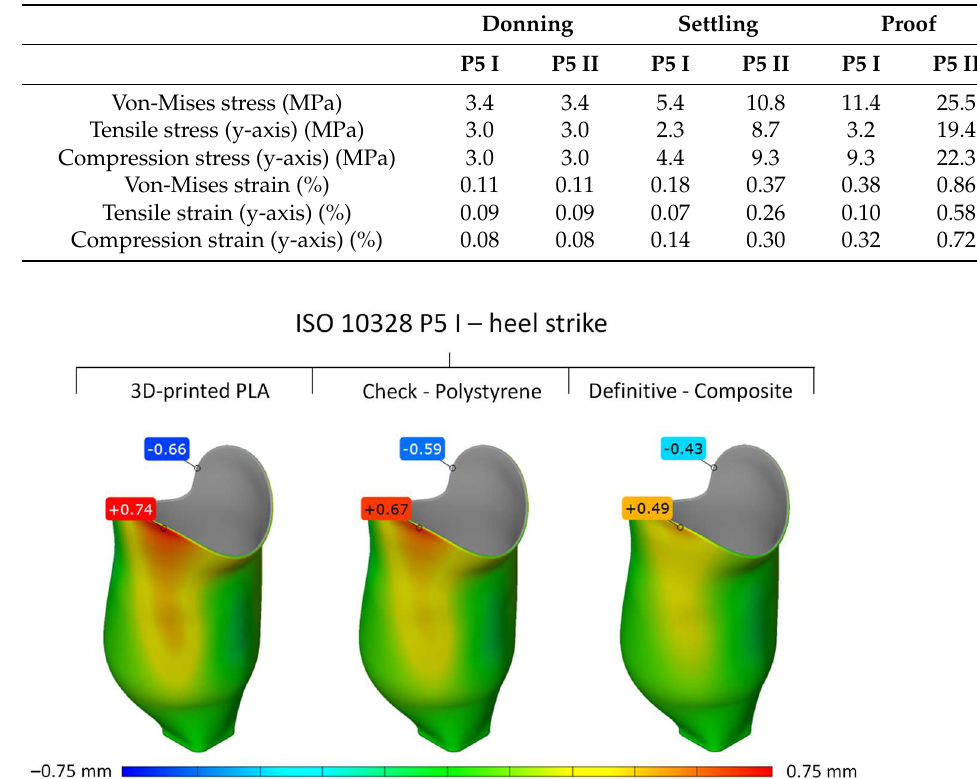
Figure 10. Global deformation of PLA, composite, and polystyrene sockets for load case P5 I at settling test force.